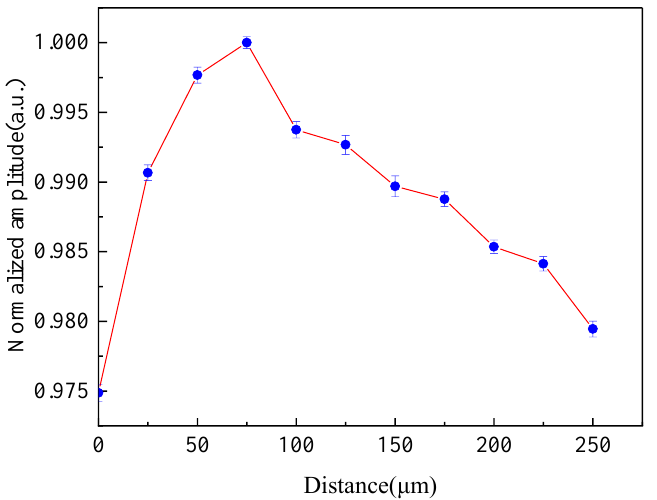
Figure 4. The QEPAS signal as a function of distance between fiber end and micro-resonator tube. Error bars show the standard deviation from 60 measurements and the magnitudes of the error bars are scaled up by 10 fold.